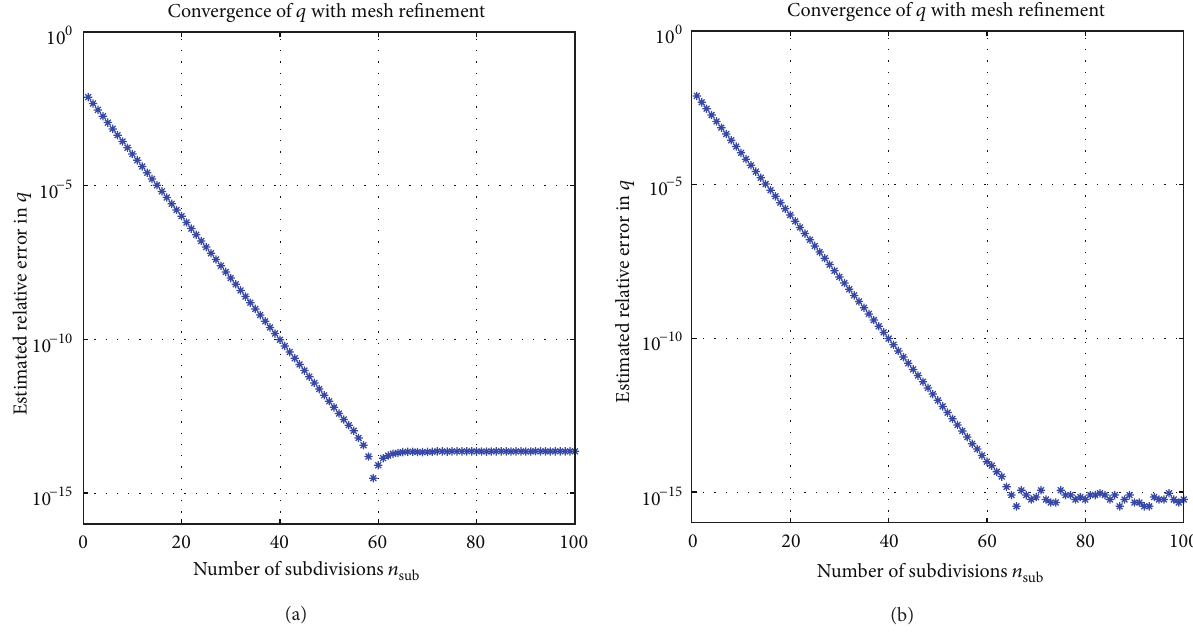
Figure 13: Convergence for 𝑞 of (6) with 𝜌 = 𝜌 1 from (42). The curve Γ is as in (1), and theta = pi/2 , npan = 11 , and evec = 1 . The reference value is taken as 𝑞 = 1.95243329423584 . (a) Results from the inner product preserving scheme of Appendix D produced with demo10.m . (b) Results with RCIP according to (47) and (48) produced with demo10b.m .